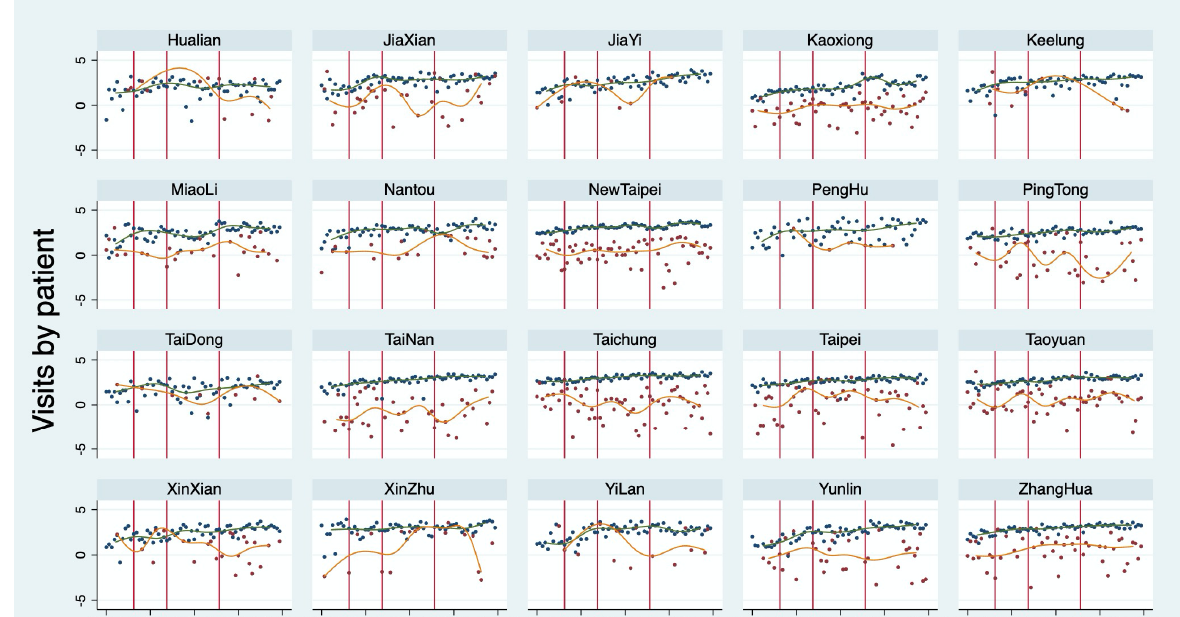
Figure 2. Total Outpatient Visits of Children with Refractive Errors by Institution Type and District. Note: Dots represent the quarterly number of total outpatient visits of children with refractive errors provided by type of facility in natural logarithms. Blue and orange denote clinics and hospitals, respectively. The smooth lines are the corresponding cubic splines. The vertical lines represent fee changes.